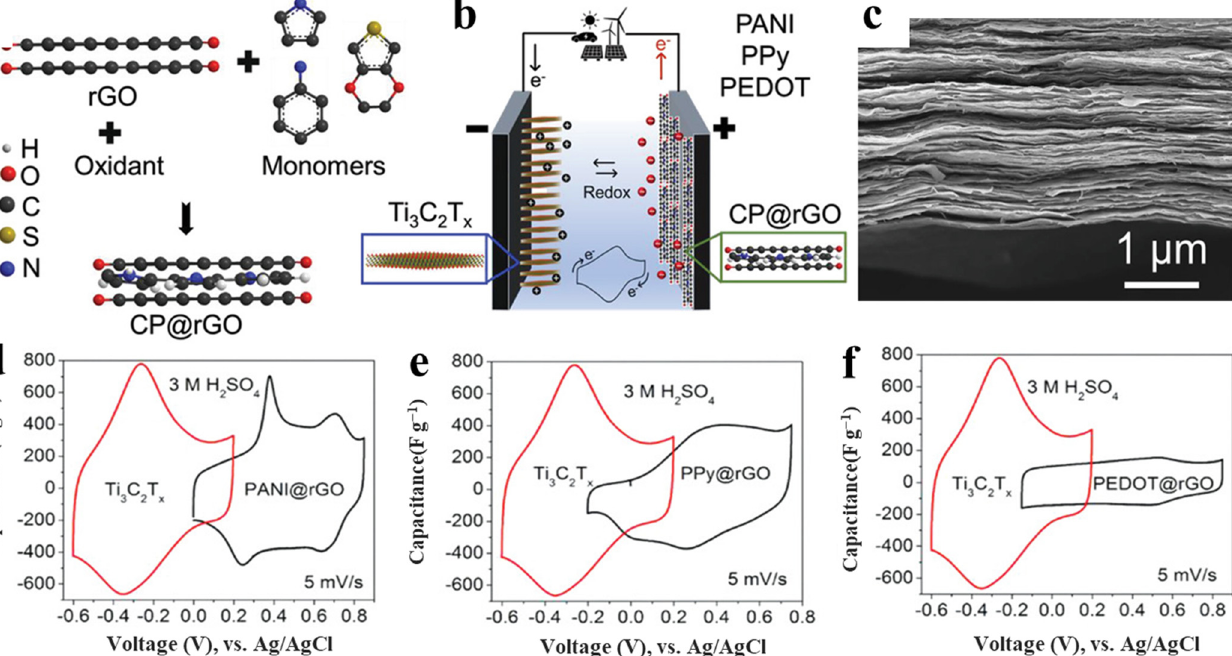
Figure 18. ( a ) An exemplification of MXene synthesis, ( b ) schematic illustration of the tests, ( c ) cross- sectional image and the ( d – i ) CV curve of the MXene-based electrodes [135]. 7.2. MXene/Metal and MXene/Metal Oxides Pseudocapacitive materials for supercapacitors include a variety of metal-based com- pounds. These materials often display below-average electronic conductivity despite hav- ing high theoretical potential. Due to the metal-like conductivity of MXene, composites consisting of MXene and metal have been investigated as a potential solution to this prob- lem. For MO, MnO 2 , MoO 3 , RuO 2 , SnO 2 , TiO 2 , NiO, WO 3 , and ZnO are often used in com- bination with MXene to obtain excellent capacitance [143–146]. MXene/MO composites can be generated by in situ processing or field assembly. A simple technique to induce meaningful interactions between components for in situ synthesis is to chemically grow metal oxides directly on liquid phase MXene nanosheets [147]. Figure 19a shows the syn- thesis procedure of CoS 2 nanoparticles’ growth on a MXene surface and a simple one-step solvent thermal method has been used for the synthesis From SEM images, it can be observed from the figure that the composite has two kinds of morphologies: one is spherical structure and the other is lamellar structure. A synergistic effect can be generated between them, promoting its electrochemical perfor- mance. Figure 19b–g represents the electrochemical tests of the MXene/CoS 2 (CCH) com- posite in 2 M KOH aqueous electrolyte. As show in Figure 19b–g, the MXene/CoS 2